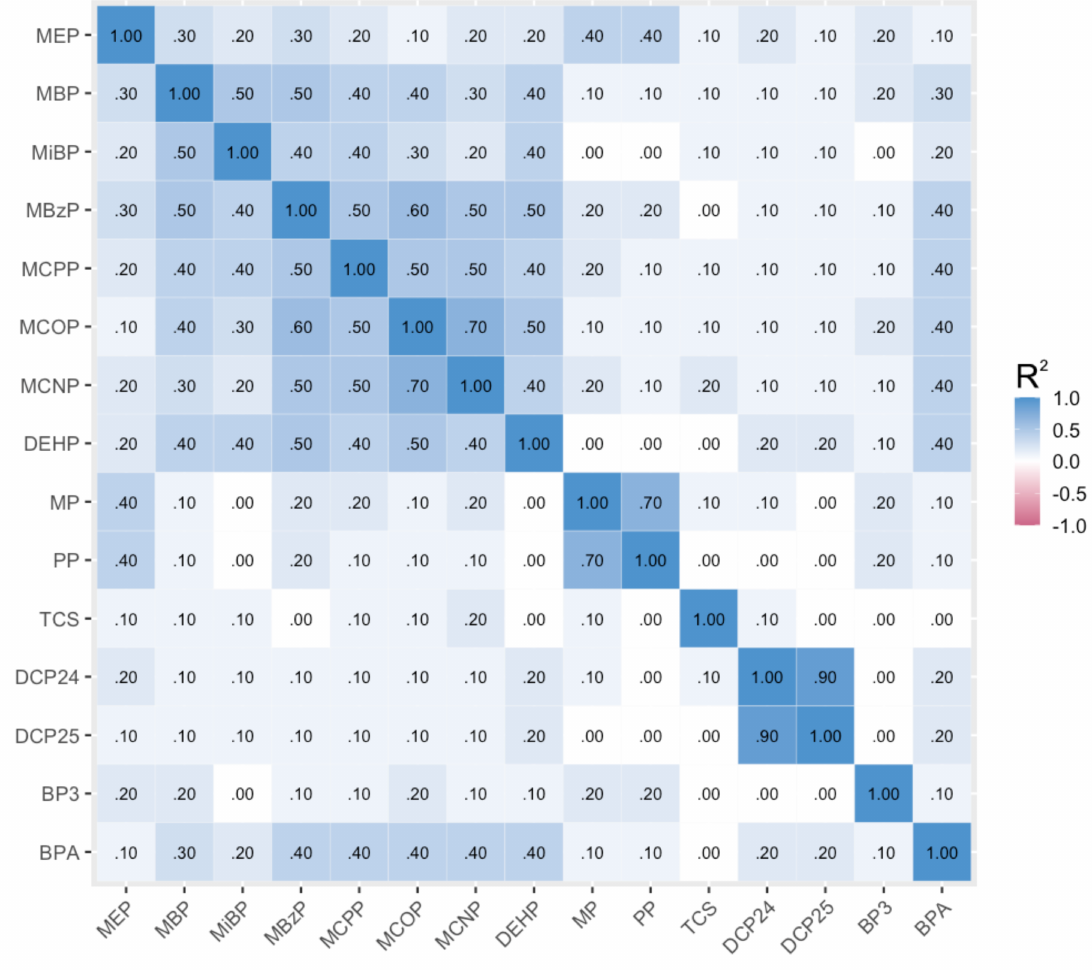
Figure 1. Correlations of log2 specific-gravity-corrected phthalate, paraben, and other phenol urinary concentrations of CHAMACOS mothers during